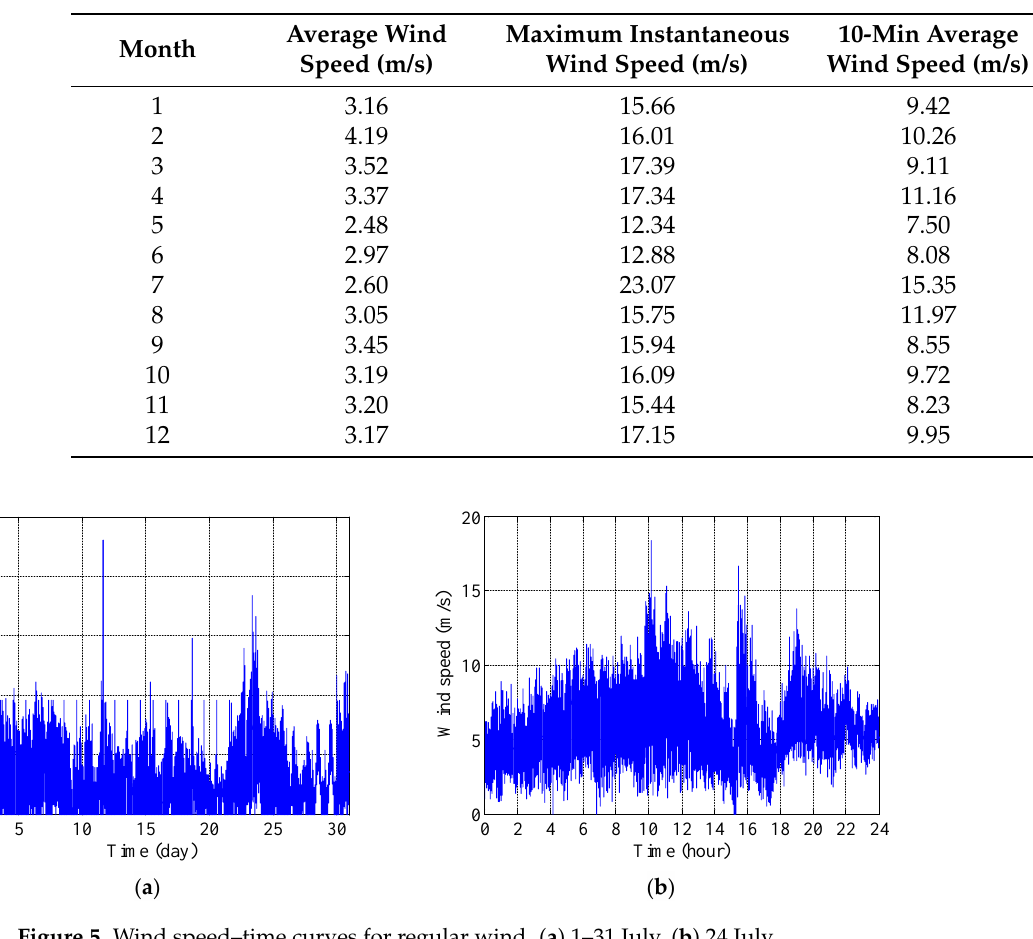
Figure 4. Variation tendency of the wind speed. Table 3. Characteristics of the monthly wind speed in 2014.